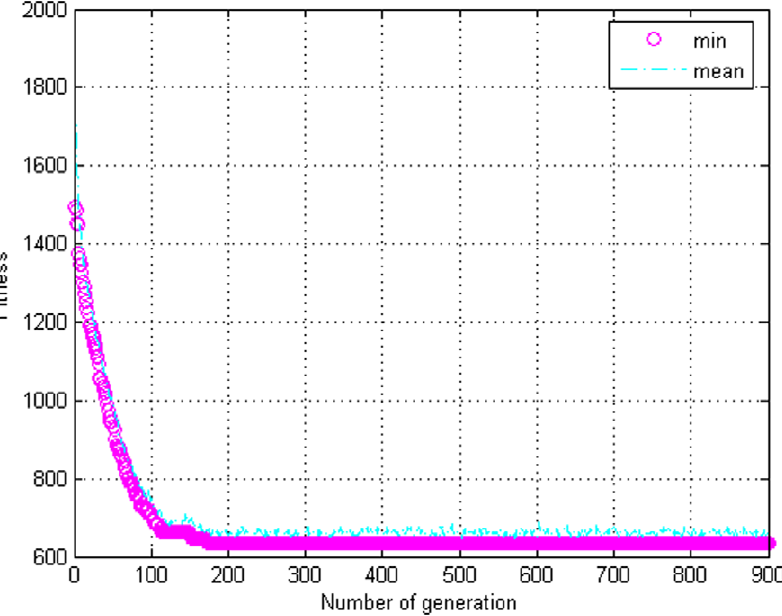
Figure 5. The sensitivity analysis related to genetic algorithm parameter.